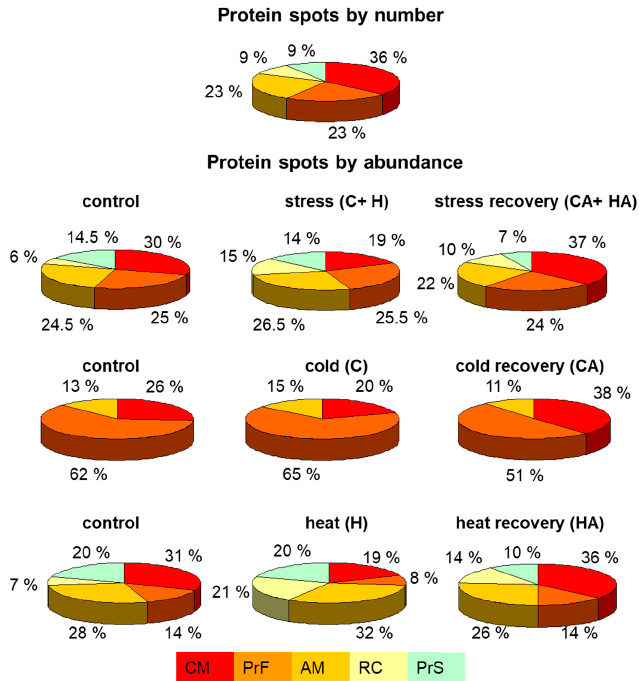
Figure 3. Functional categorization of cauliflower stress-responsive protein spots, analysed by 2D PAGE. Spots were analysed both according to their number ( upper ) as well as densitometrical volume (abundance; below ) calculated for each of functional groups in control grown plants, cold- or heat-stressed plants ( C or H , respectively) and cold- or heat-recovered plants ( CA or HA , respectively). Bar legend of categories: CM —carbohydrate metabolism, PrF —protein fate, AM —amino acid metabolism, RC —respiration (respiratory chain components), PrS —protein